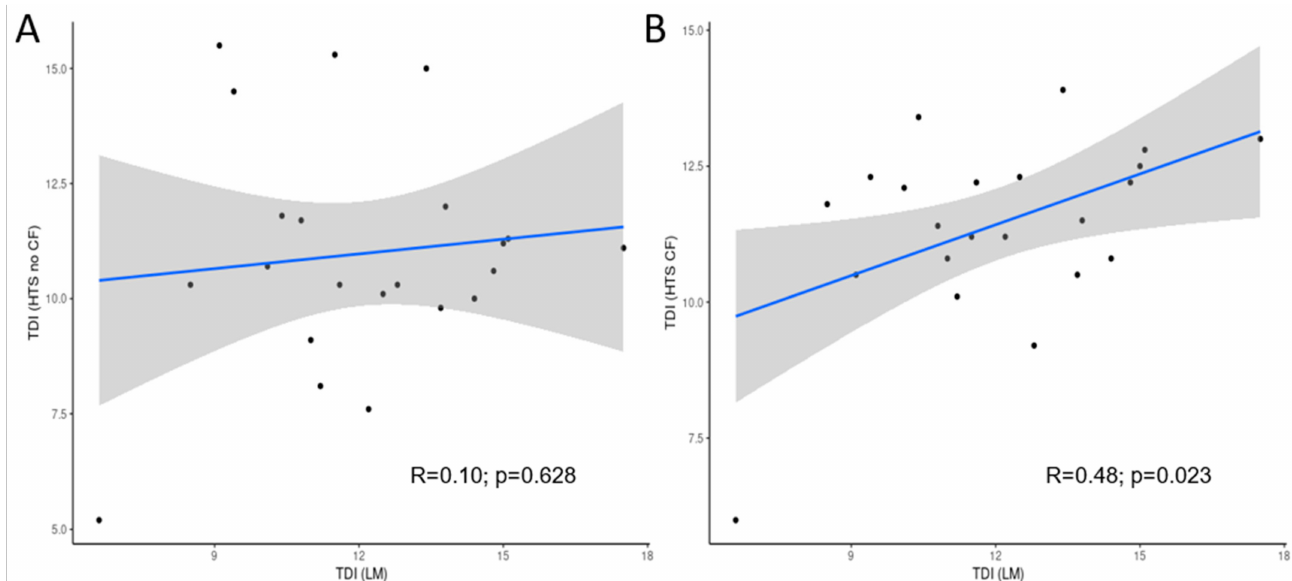
Figure 5. Correlation between Trophic Diatom Index (TDI) calculated morphological (LM) and molecular (HTS) methods, ( A ) before and ( B ) after applying correction factor. The grey bands represent 95% confidence